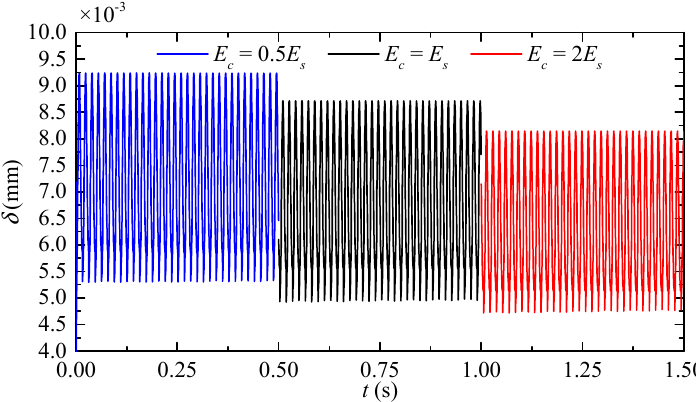
Figure 12. DTEs under different coating elastic moduli.